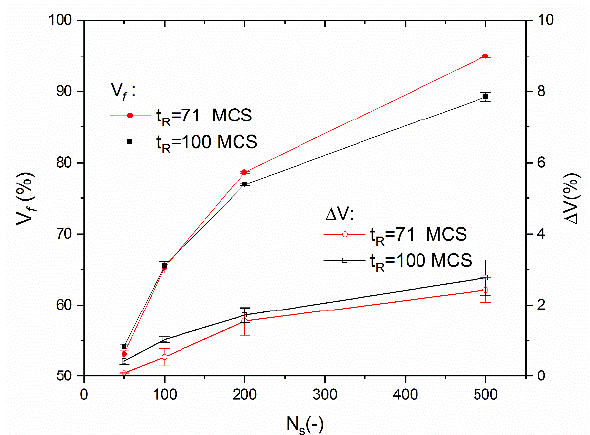
Figure 5. Measured volume ( V f ) of 3D printed cellular wrenches and comparison between the CAD and the real wrenches expressed as a relative variation of the solid phase volume ( ΔV ) as a function of the number of seed points ( 𝑁 𝑆 ) and the relaxation time ( 𝑡 𝑅 ).